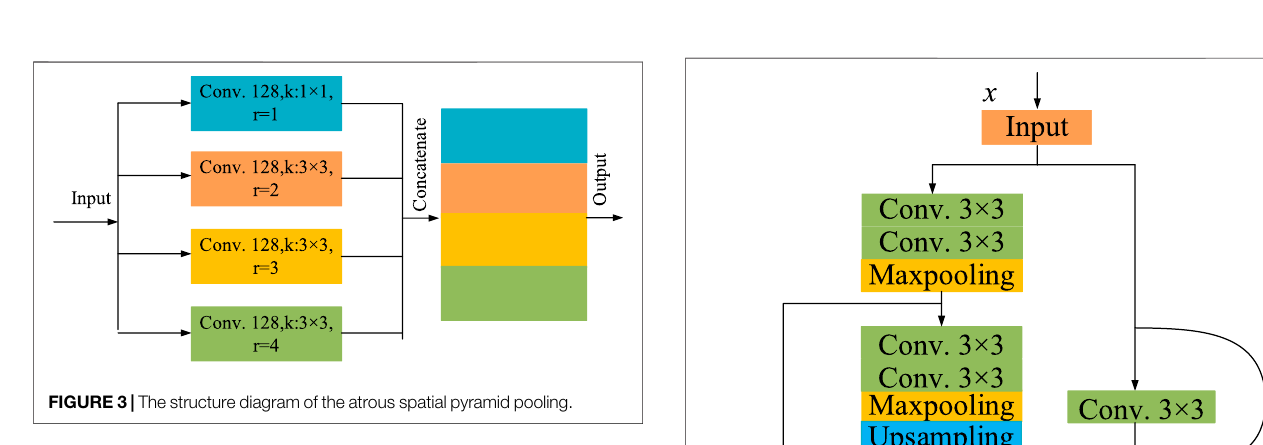
FIGURE 2 | Schematic diagram of atrous convolution with different expansion rates as (A) r (cid:1) 1, (B) r (cid:1) 2, and (C) r (cid:1) 3.